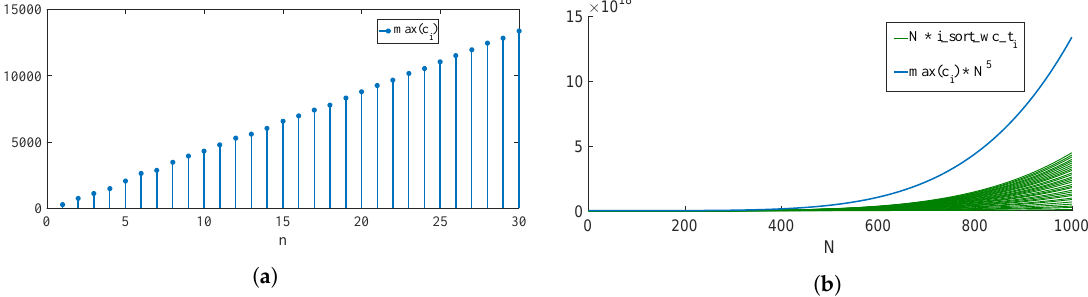
Figure 6. Asymptotic behavior of the ORCHARD algorithm for increasing cost functions. ( a ) Cost function of n ≤ 30 schedulers; ( b ) Asymptotic growth of n ≤ 30 schedulers.